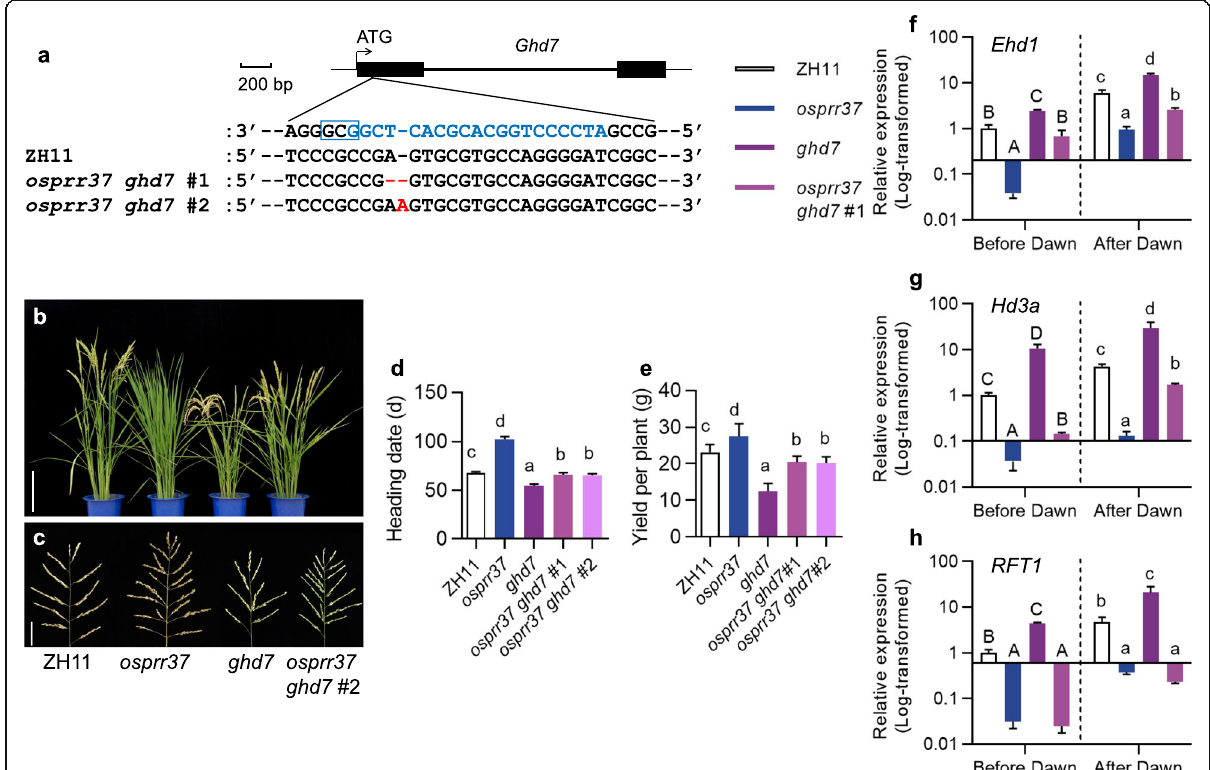
Fig. 4 Genetic analysis between OsPRR37 and Ghd7 . a Allele information of ghd7 mutant generated by clustered regularly interspaced short palindromic repeats (CRISPR) strategy. Black bars represent the exons, and solid line before, between and after the black bars represents the 5 ′ un-transcribed region, intron and 3 ′ un-transcribed region, respectively. Letters in the blue box is the protospacer adjacent motif (PAM) sequence. Blue letters indicate the targets sequence. Red letters indicate the mutation details. b-c Phenotype of whole plants ( b ) and main panicles ( c ) of ZH11, osprr37 , ghd7 and double mutants osprr37 ghd7 (#1 and #2) grown under NLD conditions. Scale bar, 25 cm in b and 5 cm in c . d-e Heading date and yield per plant of ZH11, osprr37 , ghd7 , and the double mutants osprr37 ghd7 (#1 and #2) grown under NLD conditions. Data represent mean ± SD, n = 10. Different letters indicate significant differences, Duncan ’ s test. f-h Log 10 -transformed expression levels of Ehd1 ( f ), Hd3a ( g ) and RFT1 ( h ) in ZH11, osprr37 , ghd7 and the double mutant osprr37 ghd7 . Expression of indicated genes in leaves of 40-d-old plants under controlled LD conditions were determined 2.5 h before and after dawn by qRT-PCR and shown as mean ± SD of three replicates. Rice ubiquitin gene (Os02g0161900) was used for normalization. Different upper- and lower-case letters indicate significant differences at P < 0.05 by using Duncan ’ s test to compare the expression levels of indicated genes before and after dawn,